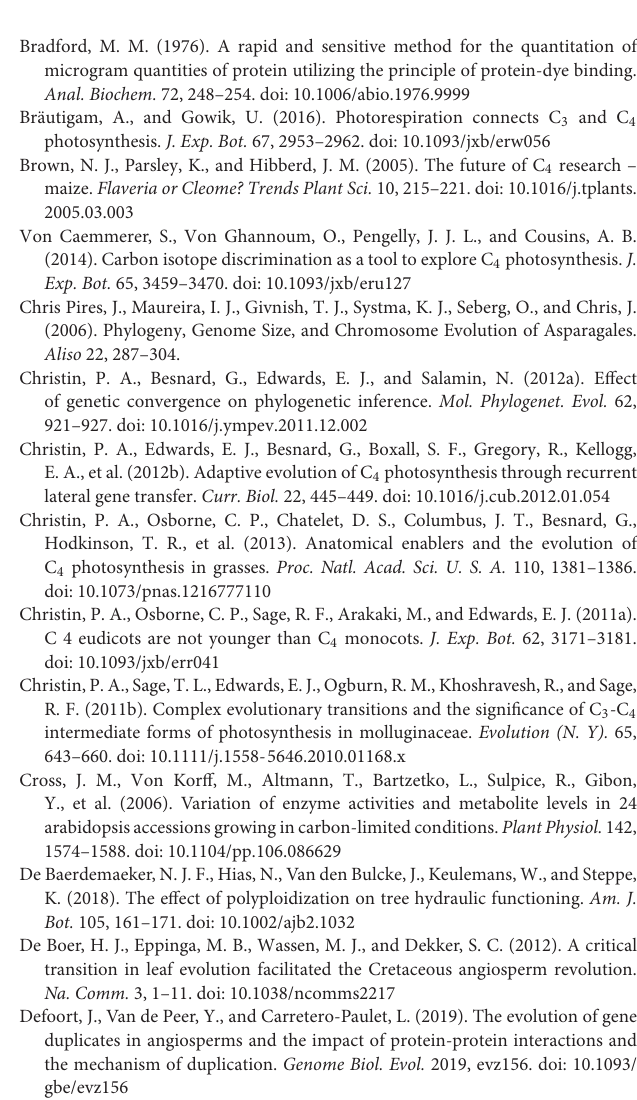
abbreviation) and